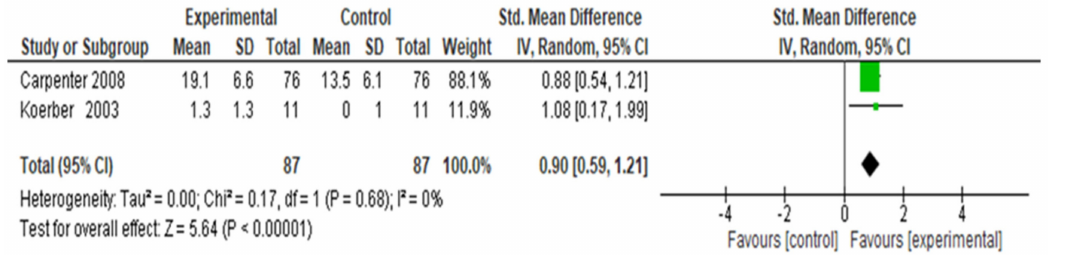
Figure 5. Forest plot for change in tobacco cessation counseling skills with standardized patients guided by Motivational